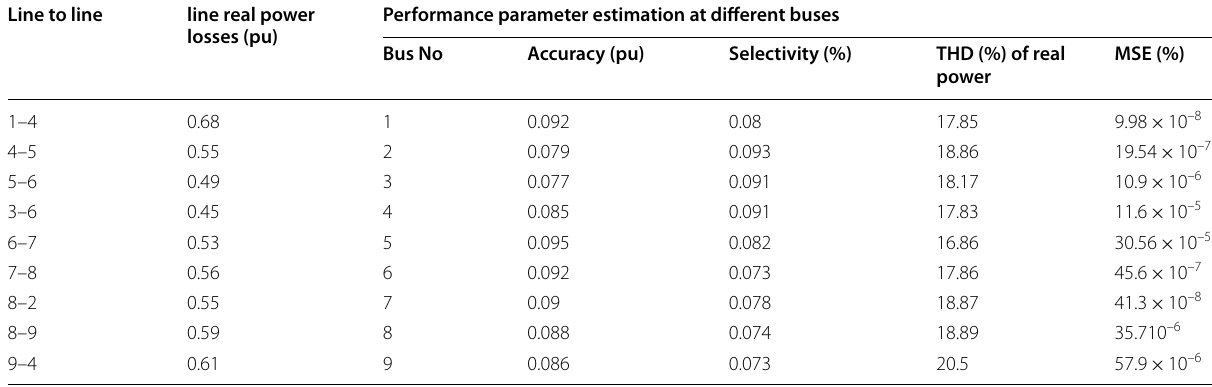
Table 3 Performance parameter analysis of standard IEEE-9 bus system using heuristic pdf method Line to